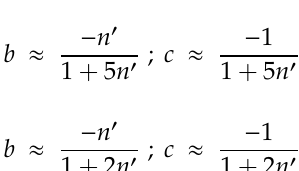
Table 2. Low-cycle fatigue (LCF) parameters of the alloy in the heat-treated and as-cast conditions. Low-Cycle Fatigue Parameters